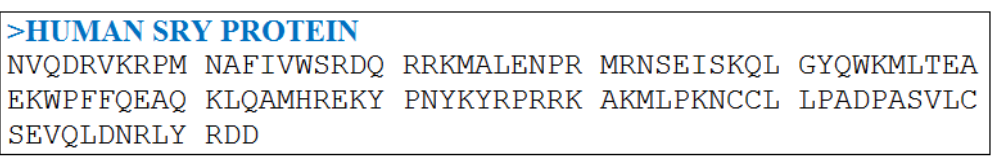
Figure 13. Human SRY Protein [15]—“the most intriguing letter ever created”.